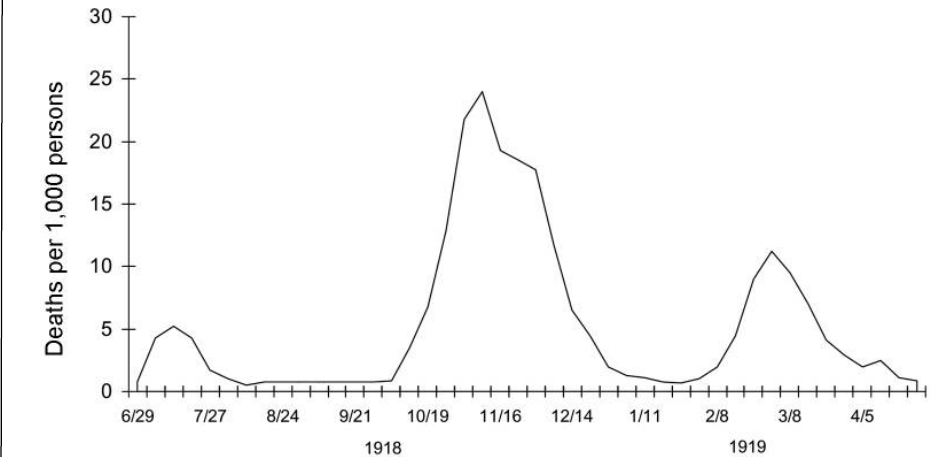
Figure 1 – Keywords: Spanish influenza deaths per thousands in the United Kingdom for the period